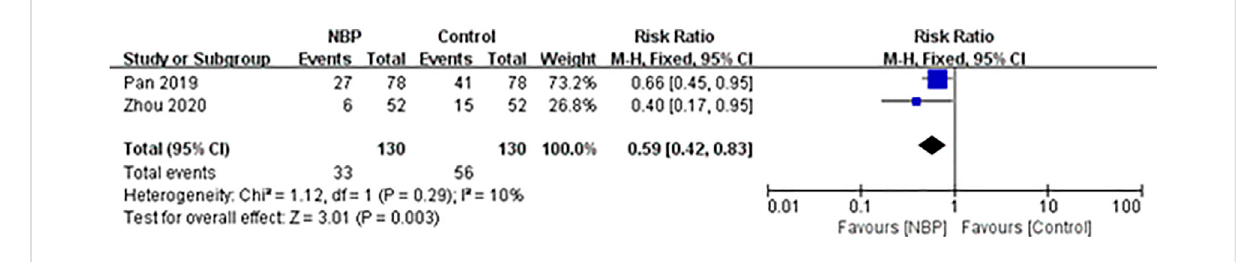
FIGURE 3 Meta-analysis of the composite outcome of death and dependency at 3-months